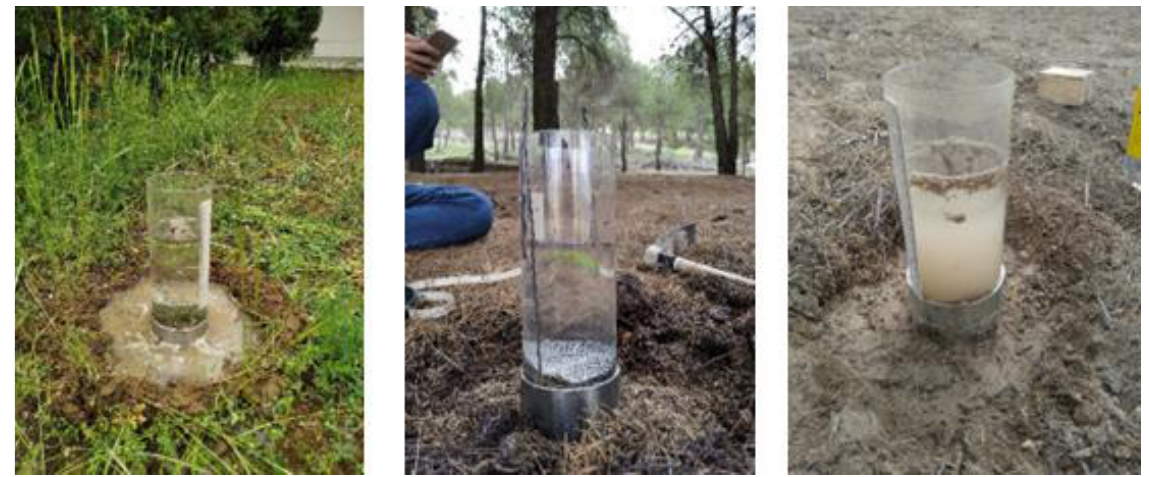
Figure 3. Simple ring infiltrometer (Infiltest).